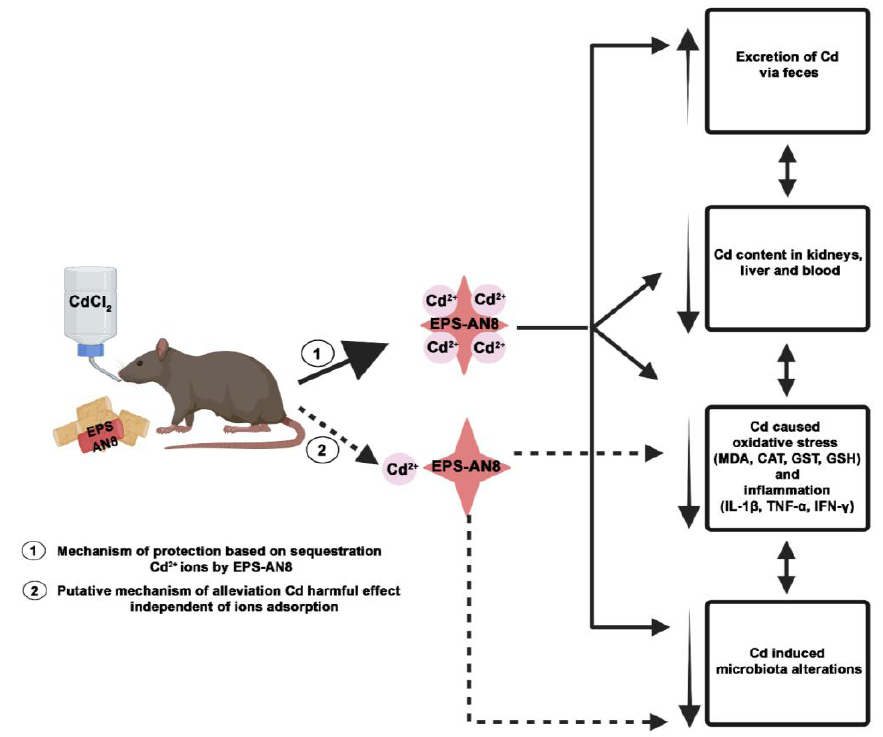
Figure 8. Proposed protective mechanisms of orally administrated EPS-AN8 against hazardous effects of Cd. Proposed mechanism marked with dashed lines remains to be confirmed. Created with BioRender.com.